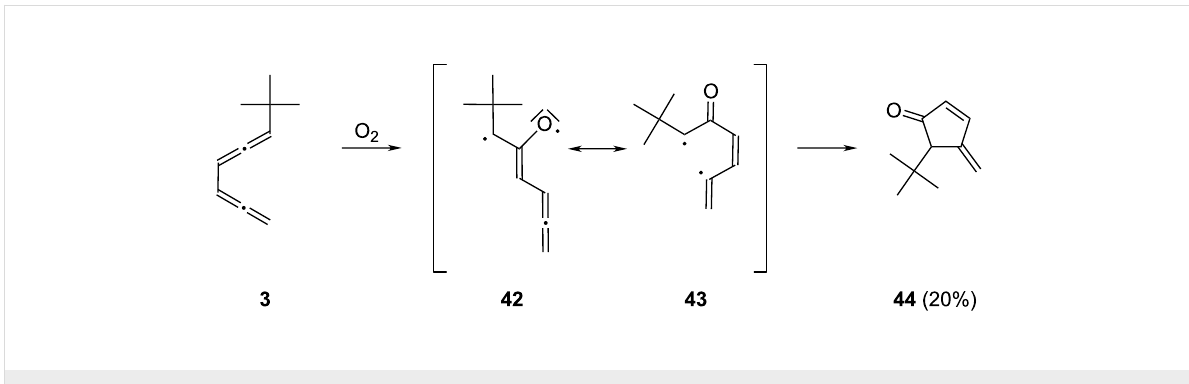
Scheme 9: Oxidation of the asymmetric bisallene 3 by air.